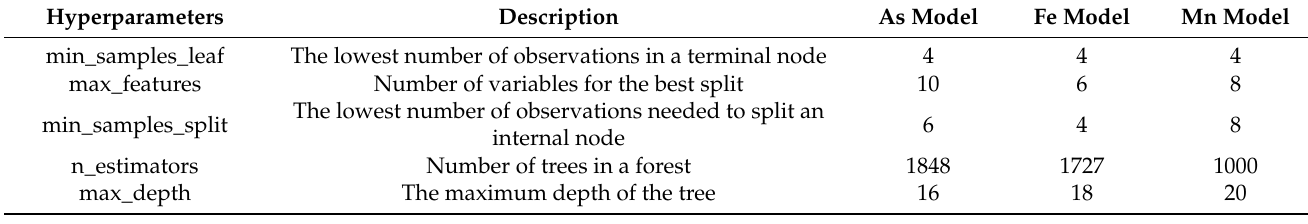
Table 3. Random Forest Regressor hyperparameter optimization.